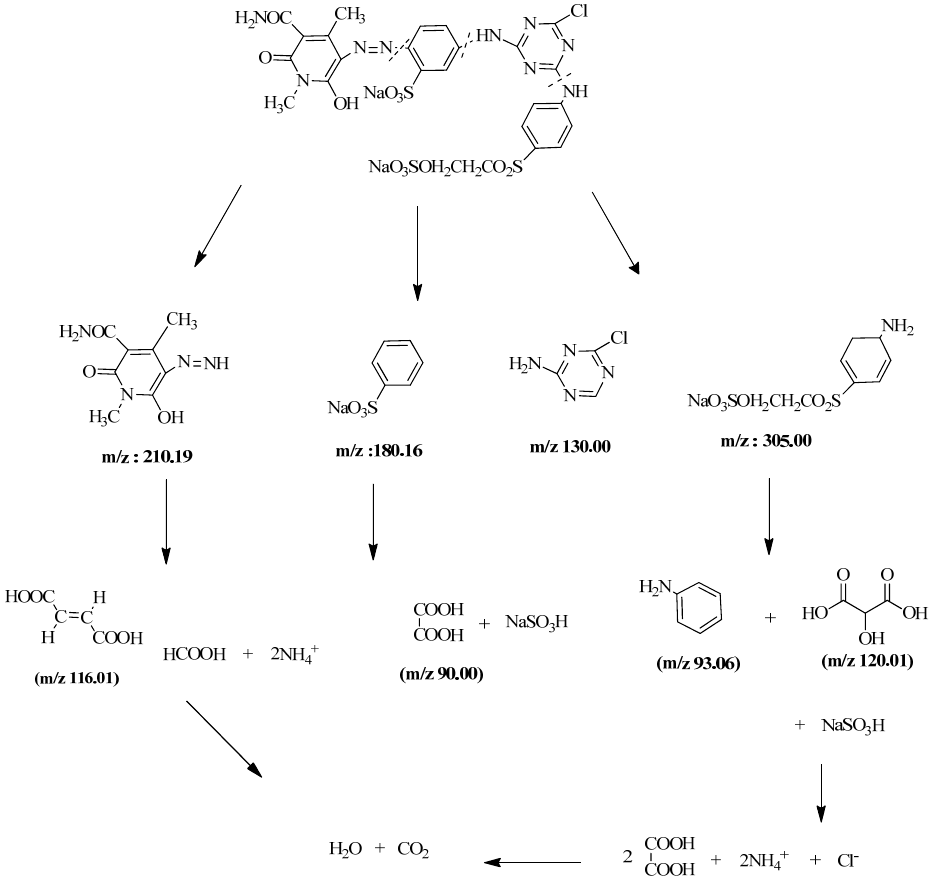
Figure 10. Proposed general mechanism for degradation of Reactive Yellow 160A. Table 2. Degradation intermediates of Reactive Yellow 160A identified by LC ‐ MS.